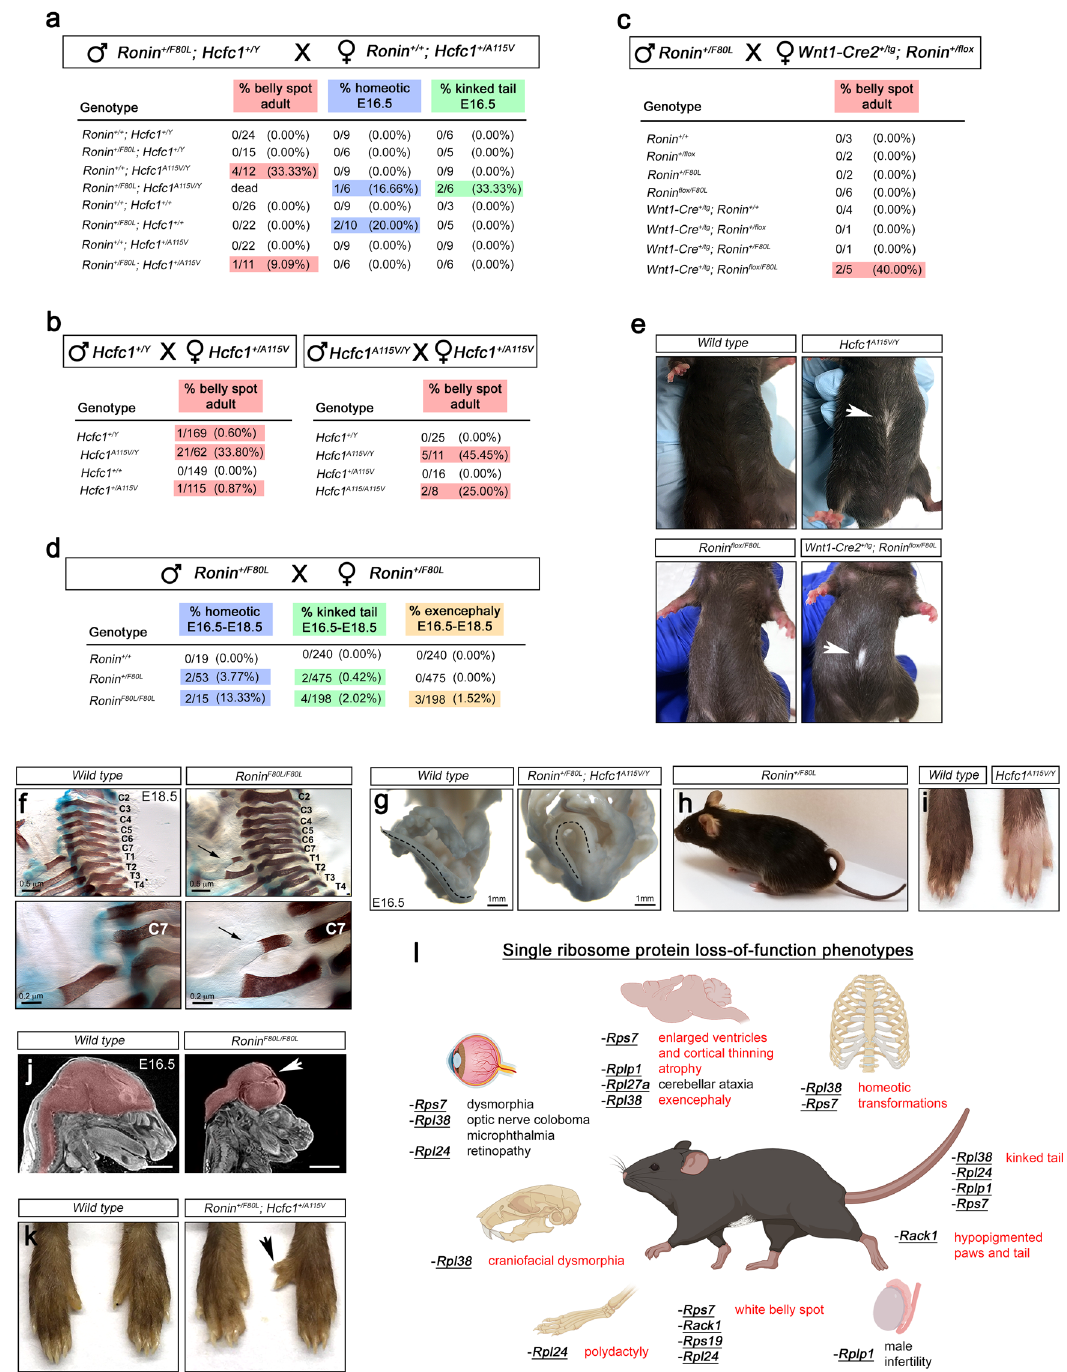
Fig. 8 Ribosomopathy phenotypes in Hcfc1 and Ronin mutants. a – d Crosses and penetrance of ribosomopathy-associated phenotypes. e White belly spotting phenotype. f Homeotic transformation of C7 to T1 indicated by an ectopic rib on C7 (arrows). g , h Kinked tails in Ronin + /F80L ; Hcfc1 A115V/Y embryos and a single Ronin + /F80L mouse. i Hypopigmented paws on Hcfc1 A115V/Y adults. j Exencephaly in Ronin F80L/F80L embryos. k Polydactyly in a Ronin + /F80L ; Hcfc1 + /A115V mouse. l Summary of phenotypes reported in single ribosome protein mutants. Phenotypes listed in red were observed in Ronin and Hcfc1 mutants, but never in wild type mice. Panel l was created with